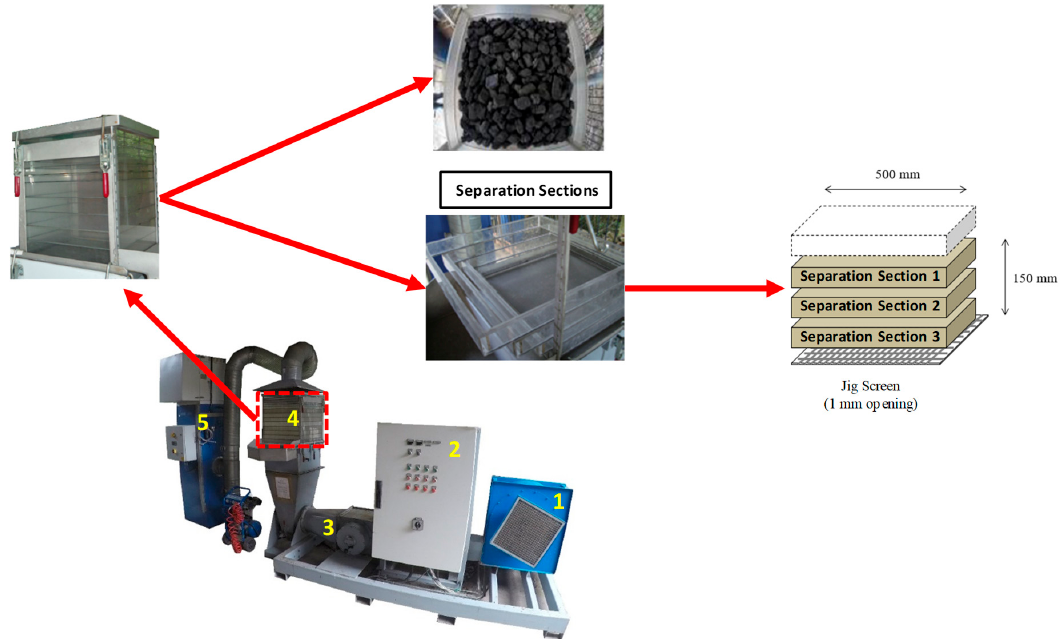
Figure 2. Air Jig AllMineral AllAir ® S-500. The AllMineral Air Jig is composed of the following components: (1) blower; (2) control panel; (3) flutter valve; (4) jig container; (5) dust collection hopper.